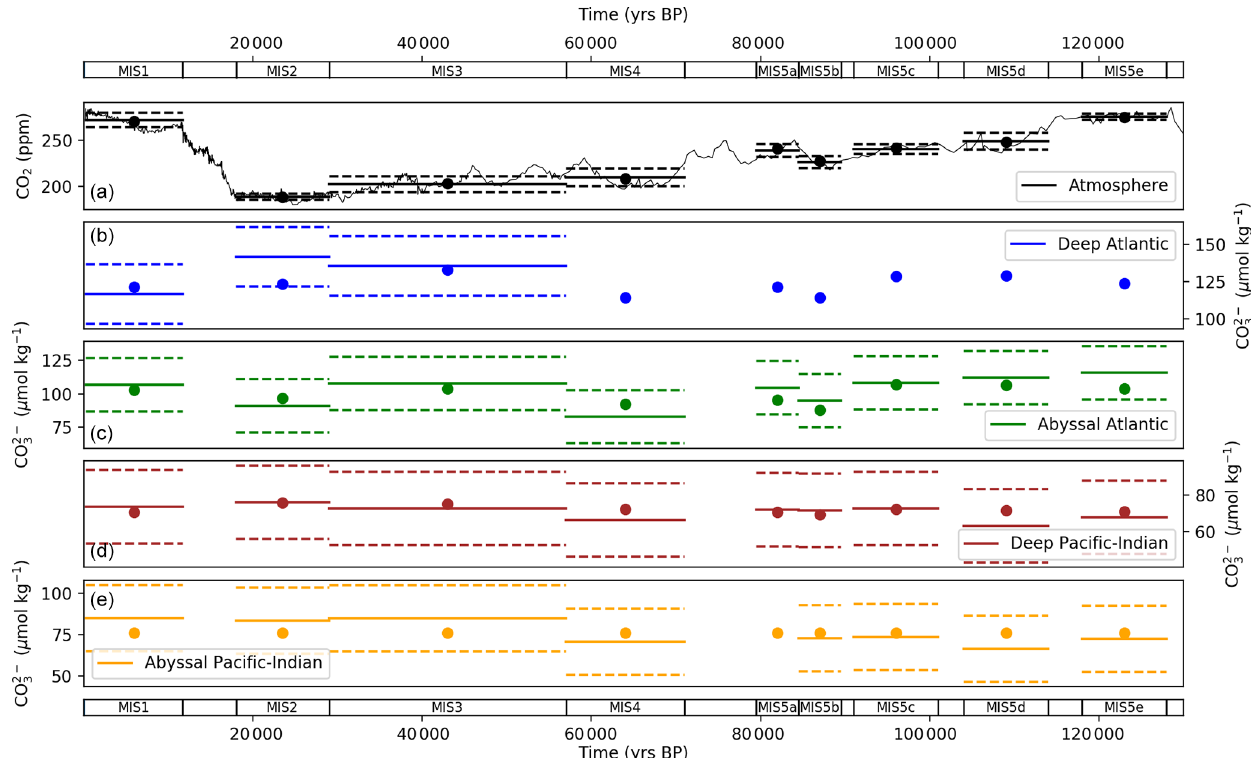
Figure 9. Values returned from the model–data experiment for (a) atmospheric CO 2 and carbonate ion proxy for (b) deep Atlantic (2500m average depth), (c) abyssal Atlantic (3700m average depth), (d) deep Pacific–Indian (2500m average depth) and (e) abyssal Pacific–Indian (4000m average depth). Model–data experiment results are shown as dots, with mean proxy data shown as solid lines and 1 standard deviation range by dashed lines, in each MIS. A default standard deviation of 20µmolkg − 1 is used as discussed in the text. CO 2 − deep Atlantic box in (b) do not extend beyond 50ka. Model results for each box in each MIS are shown in Tables S10 and